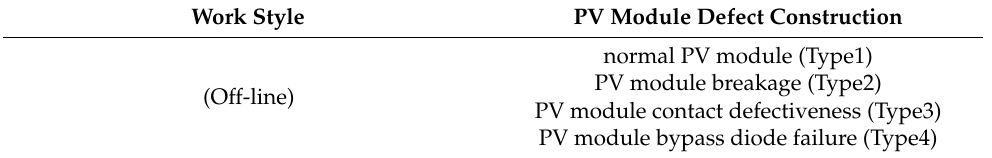
Table 1. PV module fault state models.